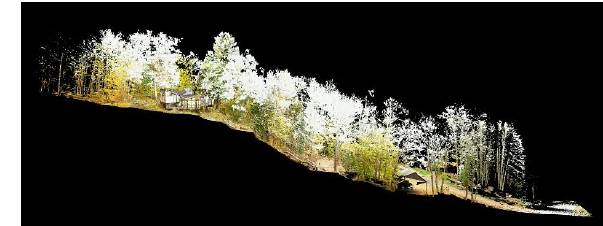
Figure 10. Image of site section from 3-D scan by Pierre